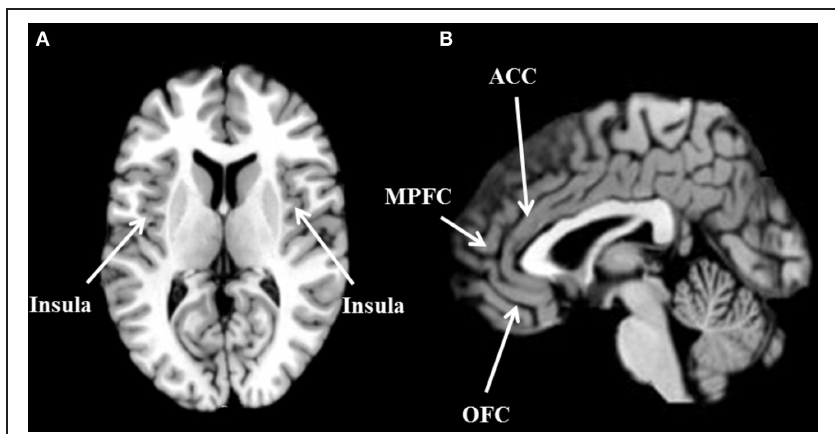
FIGURE 1 | Brain areas commonly active during empathy-related responses and decision making tasks. (A) Axial view of the bilateral insula. (B) Sagittal view of the anterior cingulate cortex (ACC), medial prefrontal cortex (MPFC), and orbitofrontal cortex